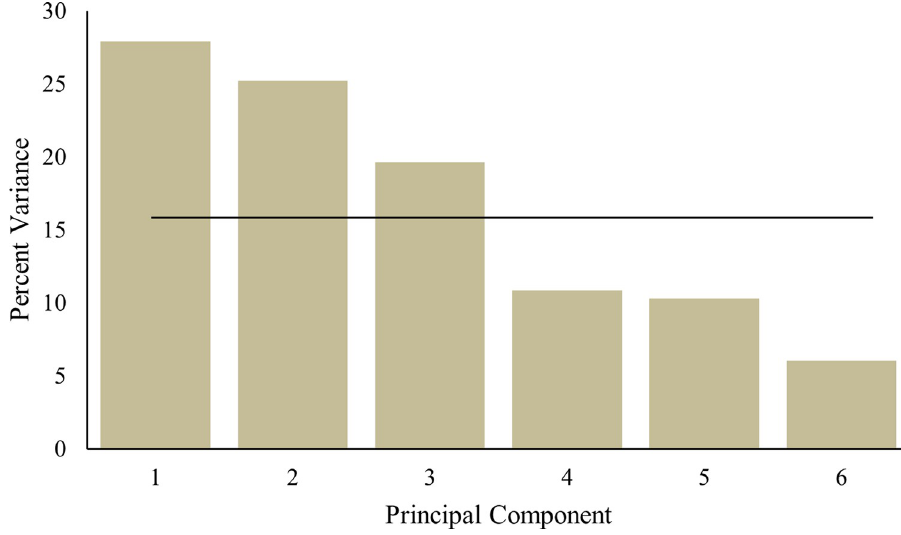
Fig 1. Scree plot of principal component analysis (PCA).